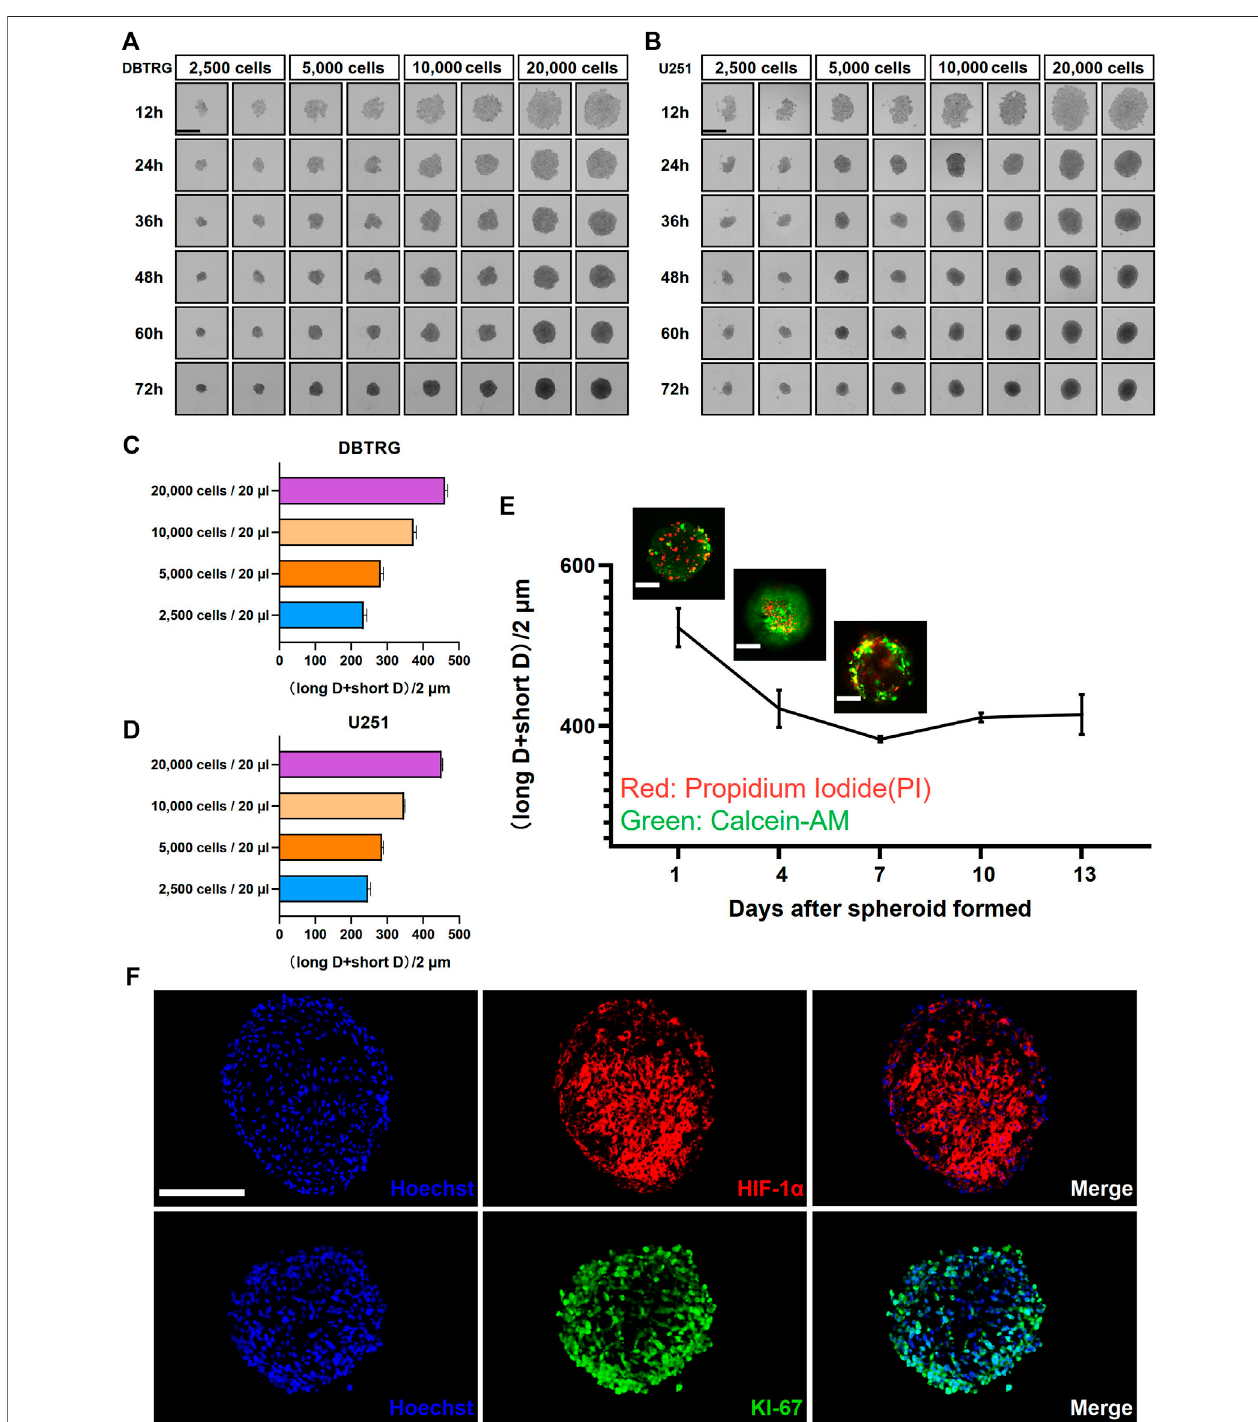
FIGURE1| Glioblastomamulticellularspheroid-formingparametersandtheirinternalheterogeneity.RepresentativeimagesshowtheformationofDBTRG (A) and U251 (B) tumor multicellular spheroids at various spheroidization concentrations. Scale bar = 500 µm. Bar graphs show the diameters of DBTRG (C) and U251 (D) Tumor multicellular spheroids generated at 72 h under different spheroid formation concentrations. (E) Growth kinetics of U251 tumor multicellular spheroids and the distribution of liveand dead cells. Scale bar = 200 µm. (F) Immuno fl uorescence staining against HIF-1 α and KI-67 on cryosectionsof tumor multicellular spheroids at day 4 after spheroid formation. Scale bar = 200